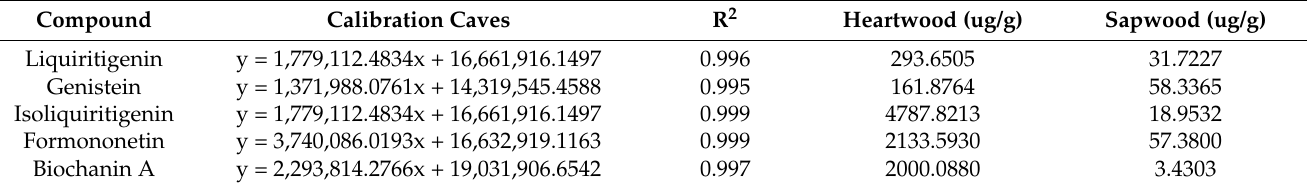
Table 4. Content of main chemical components between heartwood and sapwood of D.